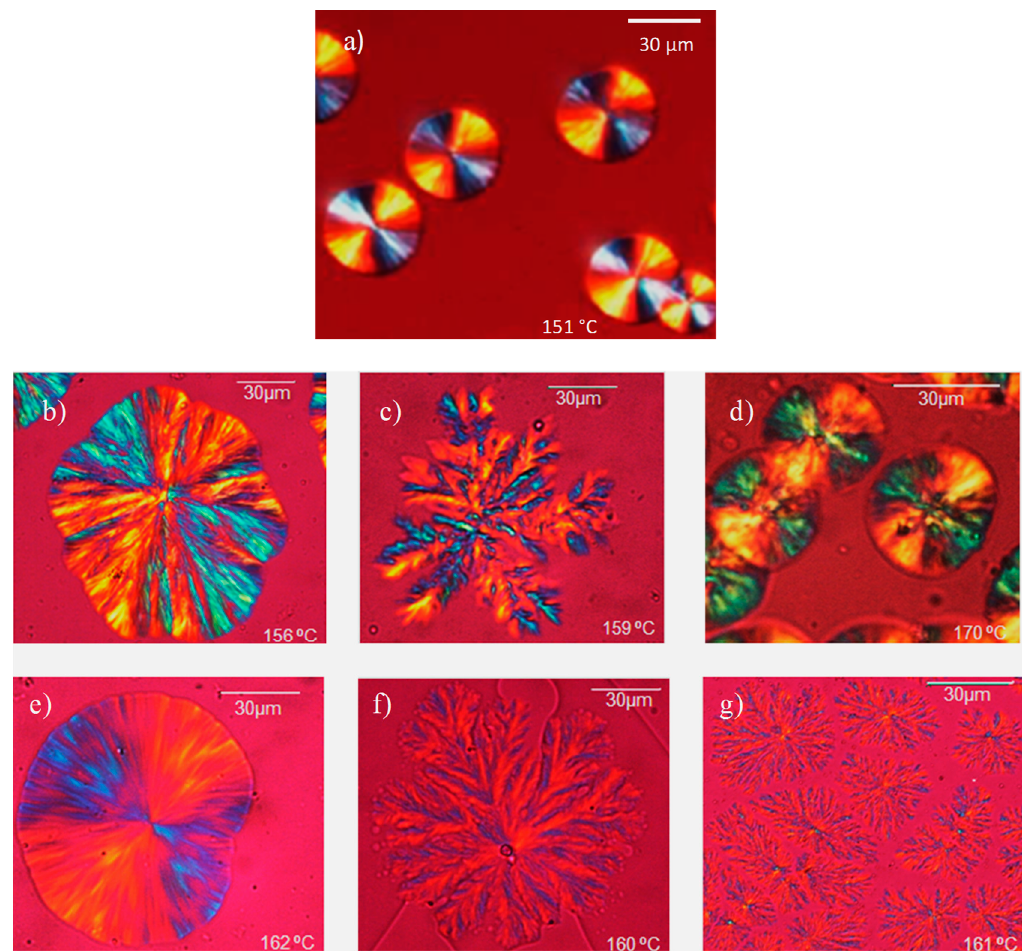
Figure 8. PLOM micrographs for ( a ) L 100 /D 100 ; ( b ) L 70 B 30 /D 70 B 30 ; ( c ) L 20 B 80 /D 20 B 80 ; ( d ) L 70 B 30 /D 100 ; ( e ) D 70 B 30 /L 100 ; ( f ) L 20 B 80 /D 100 ; and ( g ) D 20 B 80 /L 100 , during isothermal crystallization at the indicated T c .